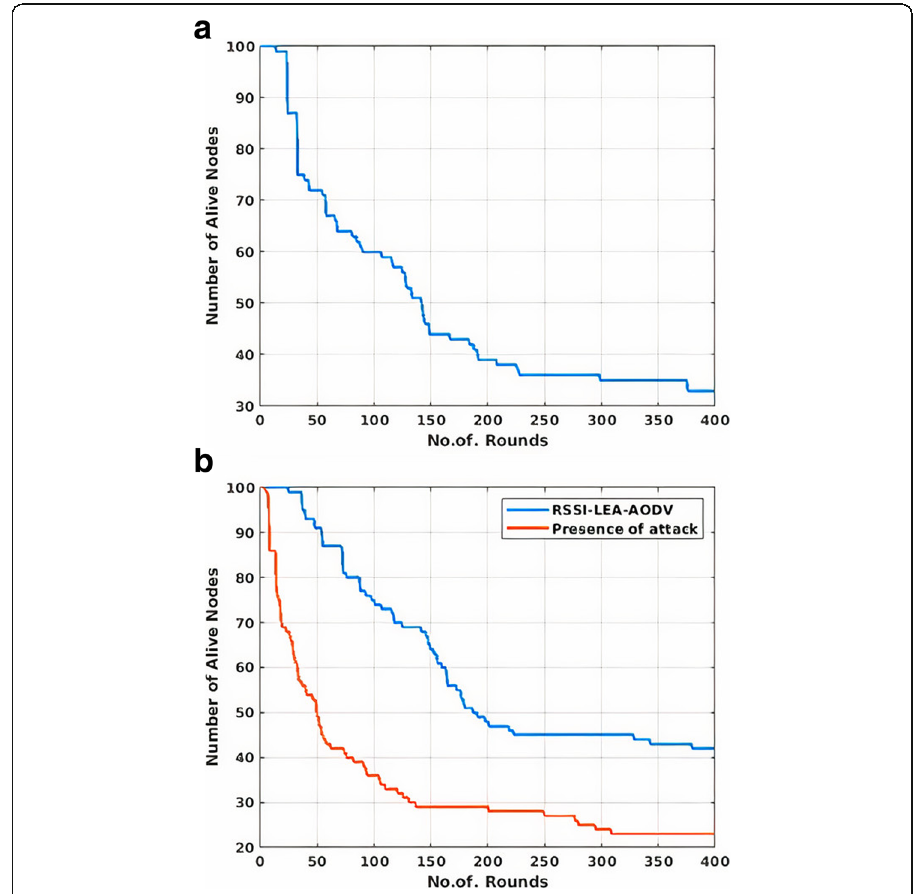
Fig. 10 a Alive nodes in the network without a Sybil attack. b Performance comparison of alive